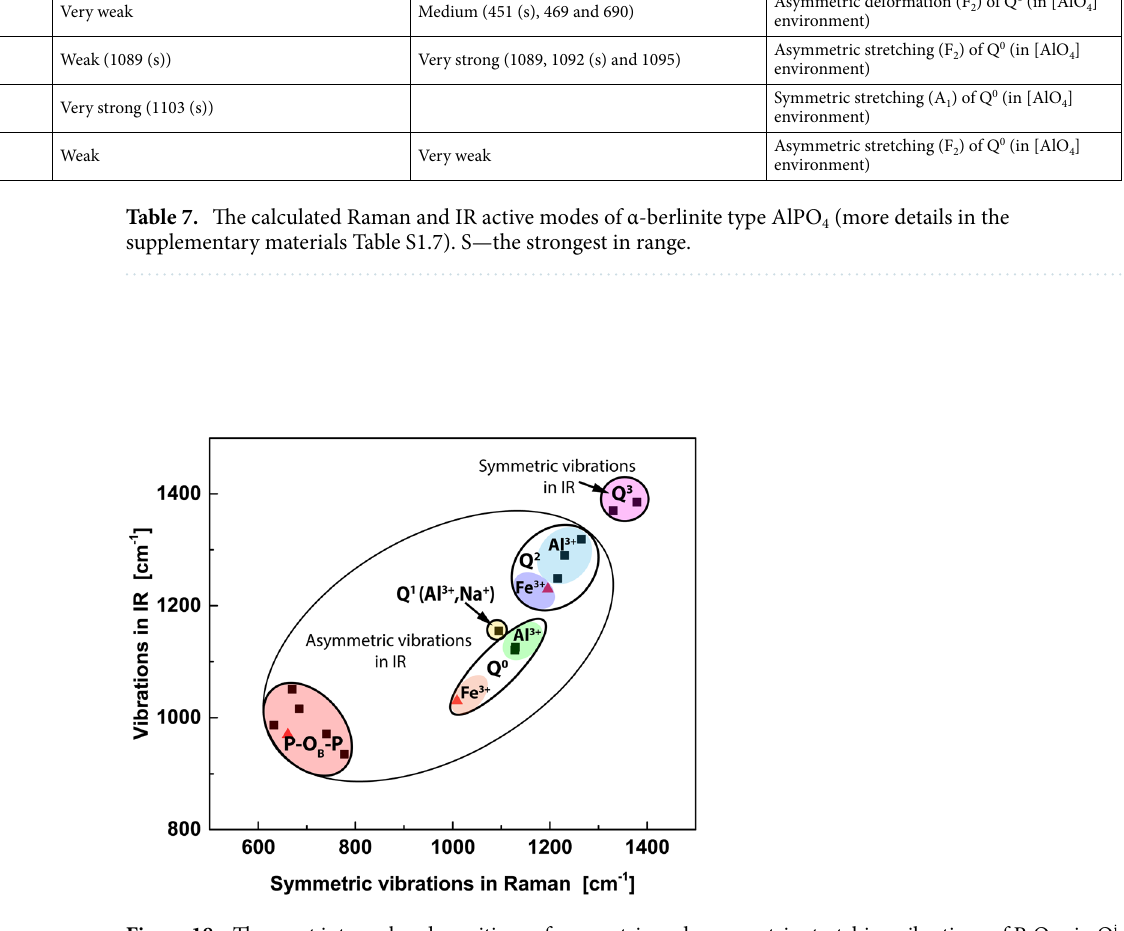
Figure 18. The most intense bands positions of symmetric and asymmetric stretching vibrations of P-O NB in Q i and P-O B -P in Raman and IR spectra. Al 3+ - vibrations in aluminum phosphates, (Al 3+ ,Na + ) in NaAl(P 2 O 7 ) and Fe 3+ in iron phosphates. Data in red triangles from 42–44